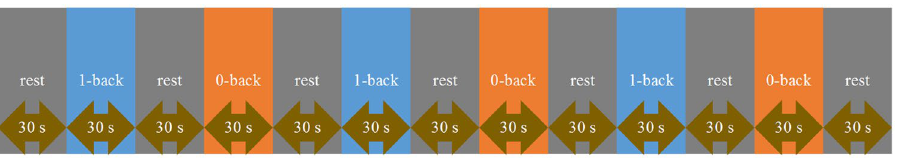
Figure 4. Schematic of the experimental procedure. The order of the task conditions was random across subjects. The adjacent two tasks were separated by 30 s periods of rest. Just one possible order was shown in this